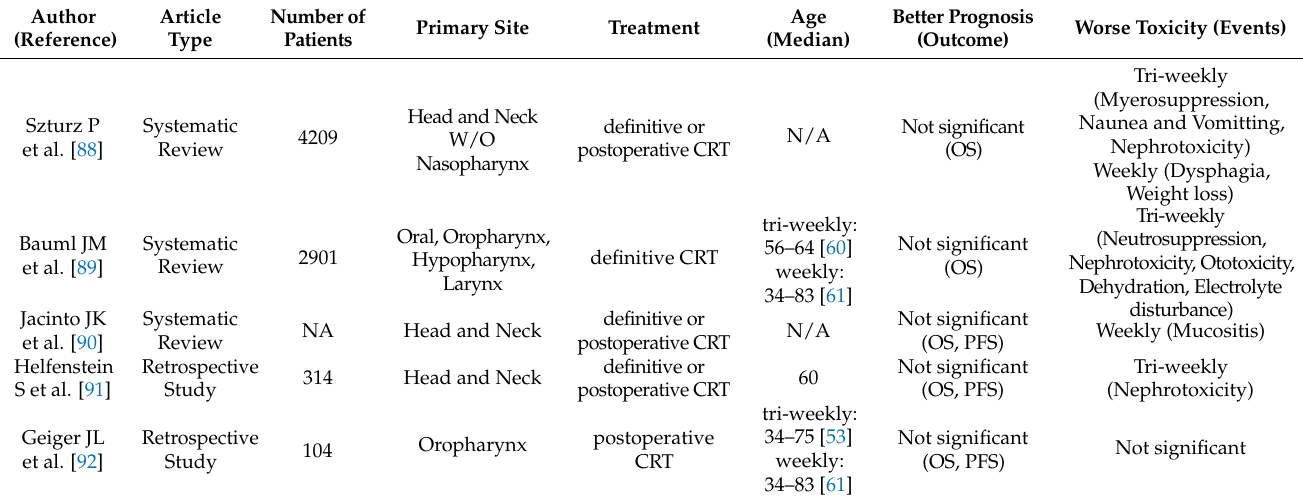
Table 3. Studies comparing tri-weekly CDDP versus weekly